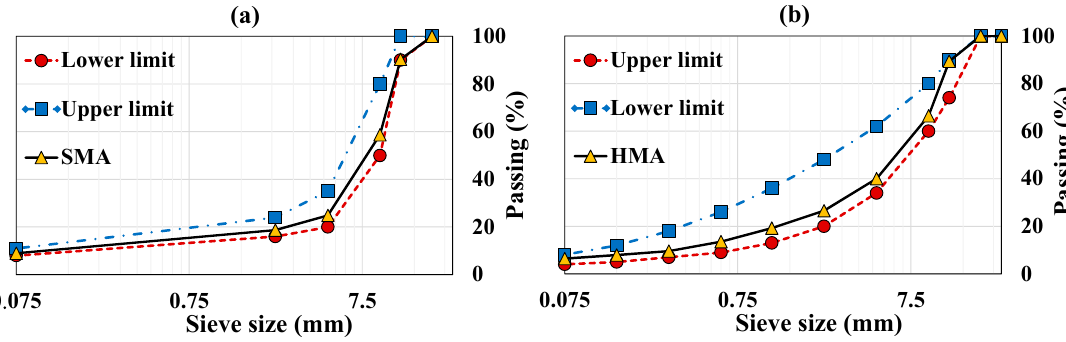
Figure 1. Mixture gradation aggregate ( a ) Stone Mastic Asphalt (SMA) samples, ( b ) hot mix asphalt (HMA) samples.